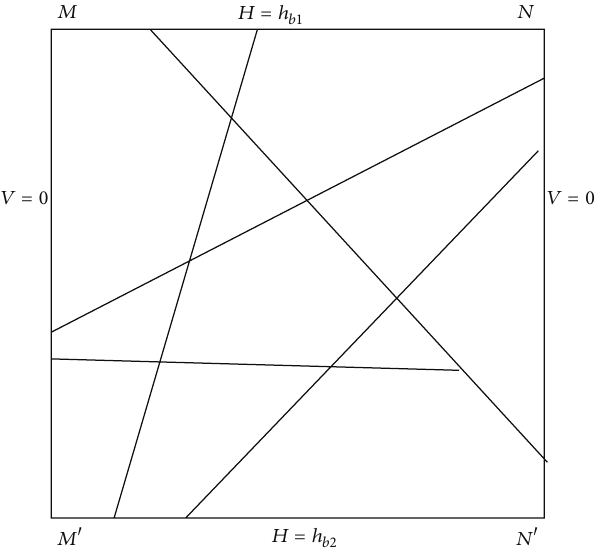
Figure 6: Fracture network schematic diagram in seepage area. MN and M 󸀠 N 󸀠 are the constant head boundaries with the hydraulic head of ℎ 𝑏1 and ℎ 𝑏2 respectively; MM 󸀠 and NN 󸀠 are the impervious boundaries with flow 𝑉 of